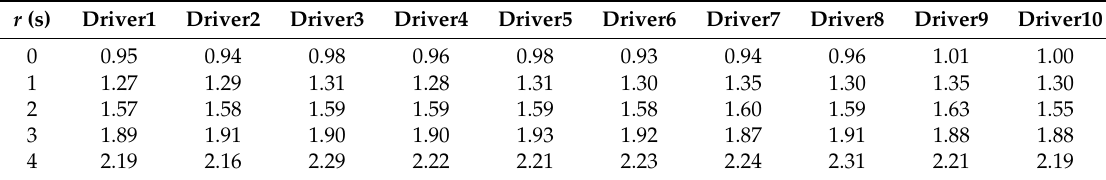
Table 12. Testing time (s) of O1.